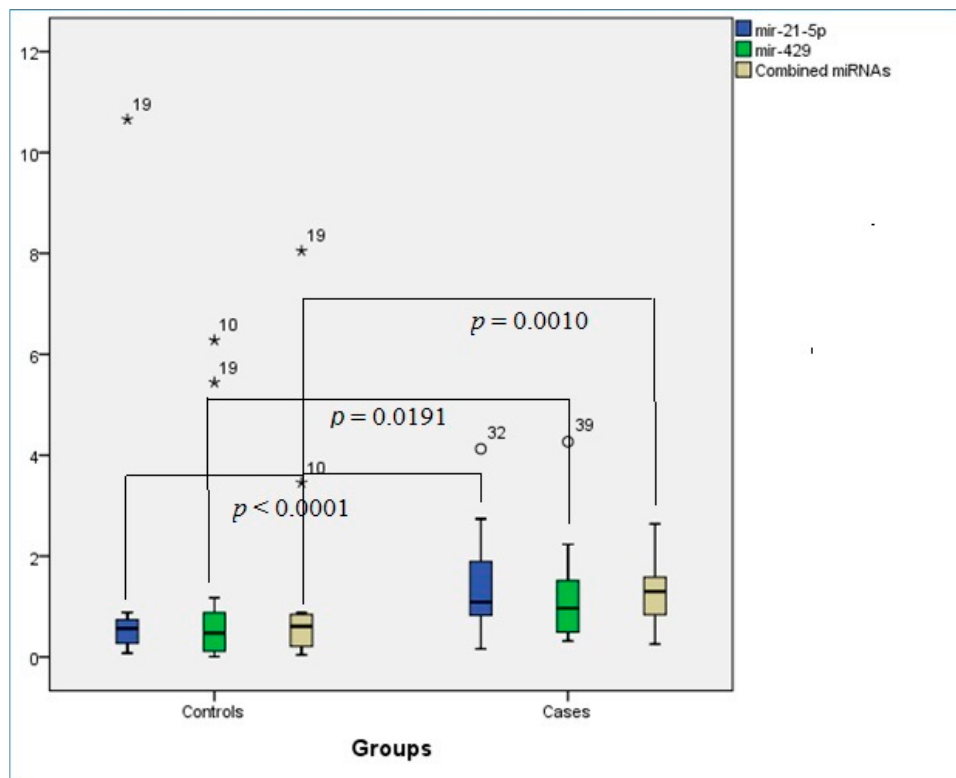
Figure 1. Distribution chart for the median expression of miRNAs among oral squamous cell carcinoma and control groups. Asterisk indicates outliers among controls and circle demonstrates